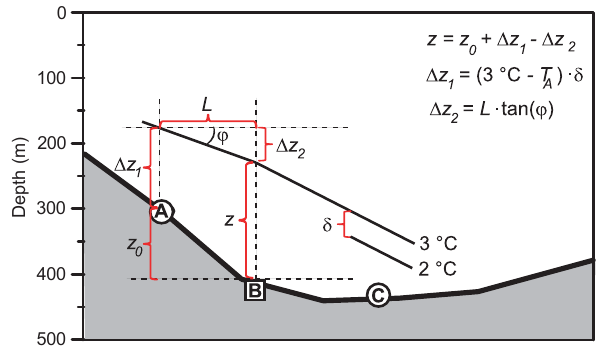
Figure 12. Sketch illustrating the determination of the height of the overflow layer at site B, z . If daily averaged bottom temperature at site B was > 3 ◦ C, z was set to zero. Otherwise, z was required not to be less than a minimum value of 25m.